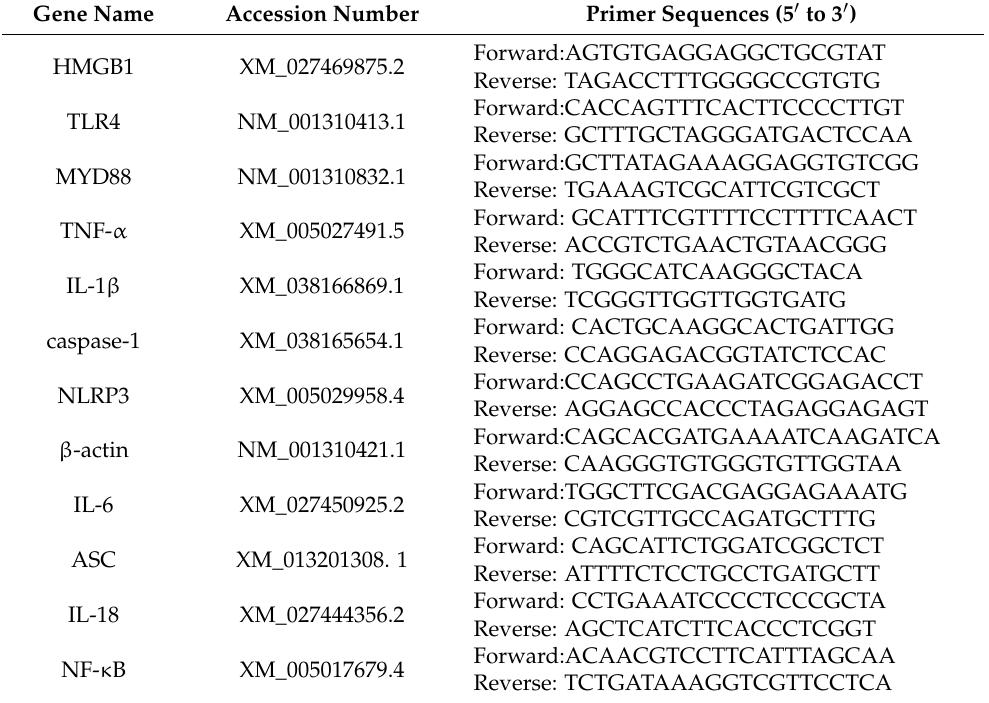
Table 1. Gene primers sequence and their GenBank accession